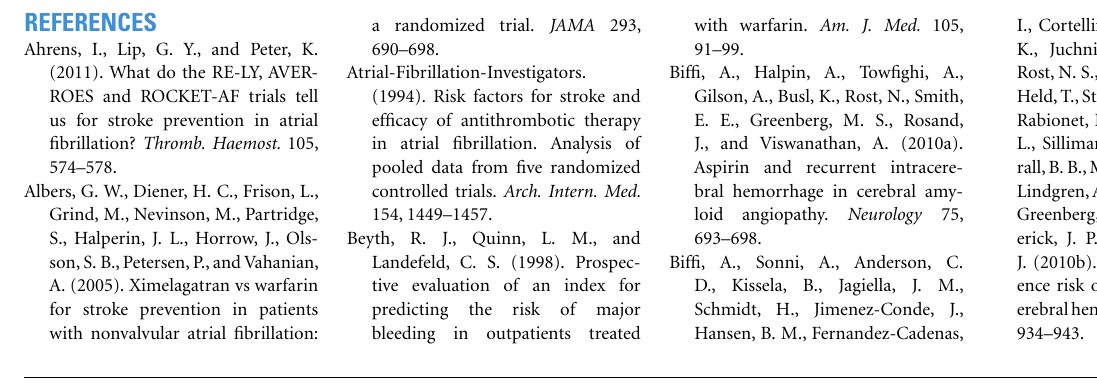
monitoring disease progression. Neuroimaging modalities and findings with potential clinical implications include: (A) cerebral microbleeds on axialT2*-weighed gradient-recalled echo or susceptibility-weighted imaging; (B) white matter changes on axialT2-weighted MRI; (C) amyloid-b load on PET images using radioligands (e.g., Pittsburgh compound B); and (D) small acute ischemic lesions (possibly cerebral microinfarcts) on axial diffusion-weighted